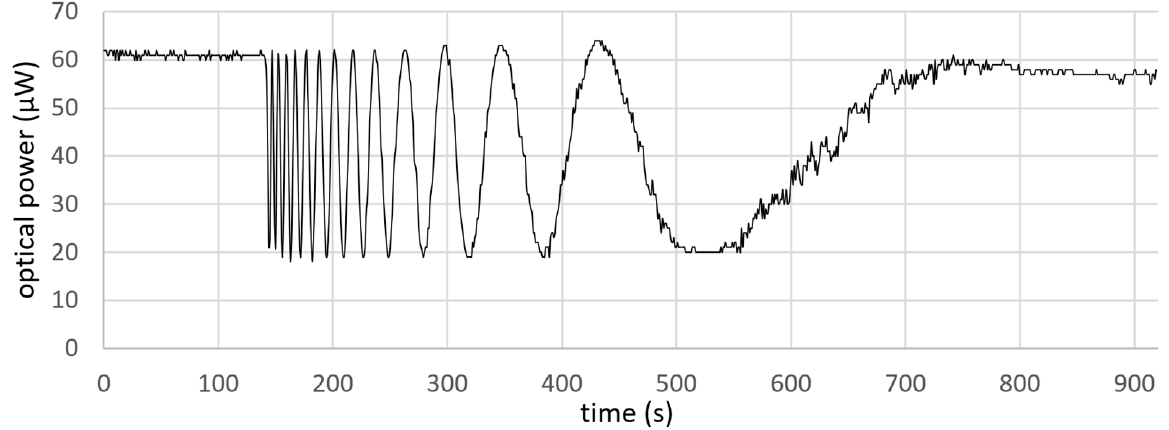
Figure 11. Simpli fi ed connection of the PM sensor measurement on the ampli fi ed optical path (EDFA). SFP—light source, EDFA—ampli fi er, LP—linear polarizer, BEAON—Brno Experimental Academic Optical Network.